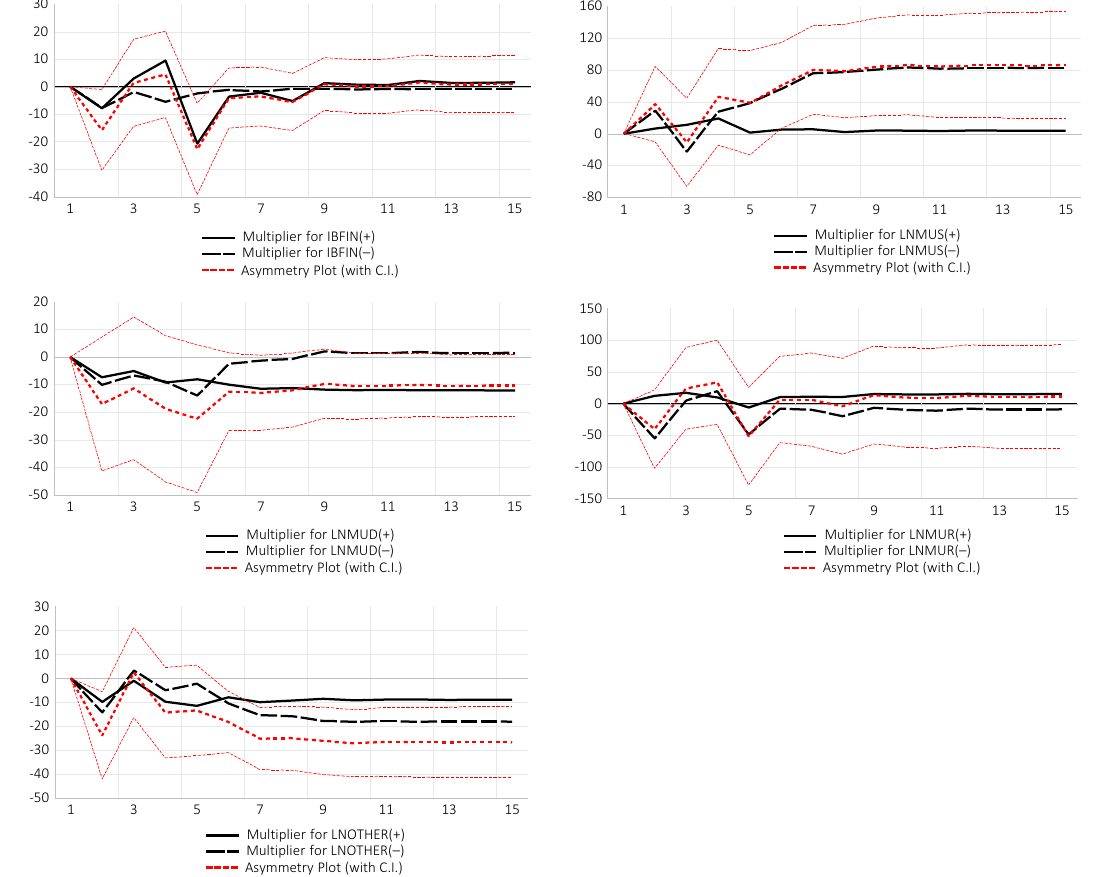
Figure 2. Influence of Islamic bank financing on financial stability